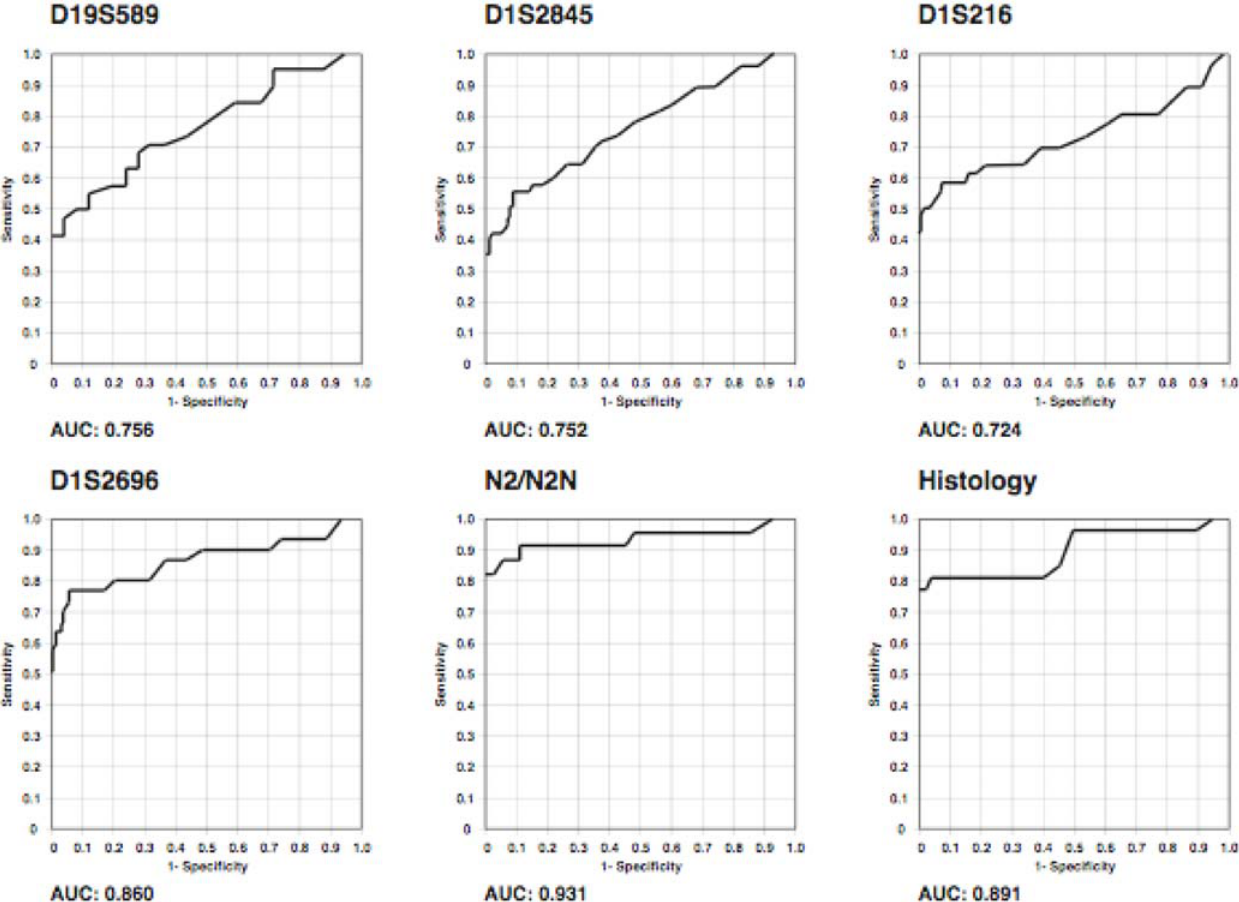
Figure 4. The N2/N2N test provides the highest accuracy to predict glioma patient survival. Receiver Operating Characteristics (ROC) curves indicating the specificities (or 1-specificities, respectively) and the corresponding sensitivities at continuously varying cut-off points for survival time. Thus, a given cut-off (particular survival time), the test result was determined for all individual tests (based on either molecular markers D19S589, D1S2845, D1S216, D1S2696, N2/N2N, or histology) as being true or false positive, or true or false negative, respectively. Based on these data, the specificities (or 1-specificities, respectively) and sensitivities calculated for each of the cut-off points. doi:10.1371/journal.pone.0000576.g004 were calculated for 24, 36 and 48 months, were optimized for marker D1S2696 together with the 19q status (0.800) were slightly discrimination of prognostic accuracy (Table 3). The N2/N2N test higher when compared to the combined use of telomeric D1S2845 and the histological classification ( i.e. OD vs. GBM) were used for and 19q status (0.762). However, using the centromeric marker stratification to determine the negative and positive predictive D1S2696 in combination with the N2/N2N test, the accuracy to values. The accuracy to predict survival of the centromeric 1p predict survival (more or less than 24 months) was 0.925, which Table 3. Receiver operating characteristics for molecular markers D1S2696 and the N2/N2N-assay and tumor classification